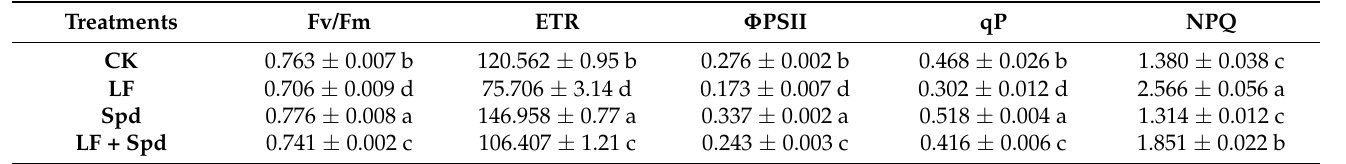
Table 5. Effects of exogenous Spd on fluorescence parameters in tomato leaves under low-iron stress.